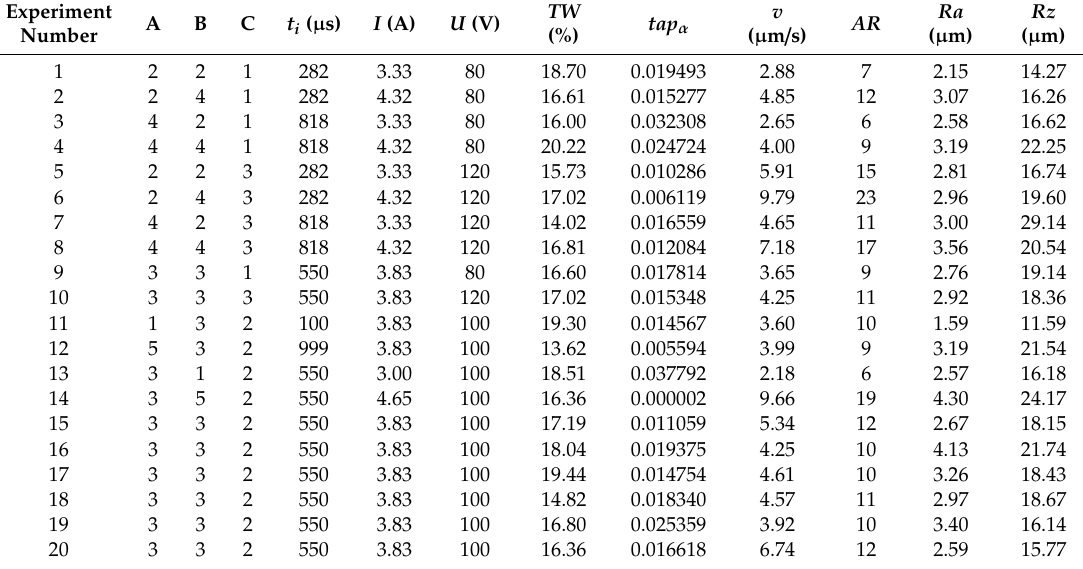
Table 5. The research plan and the results of the experiments.